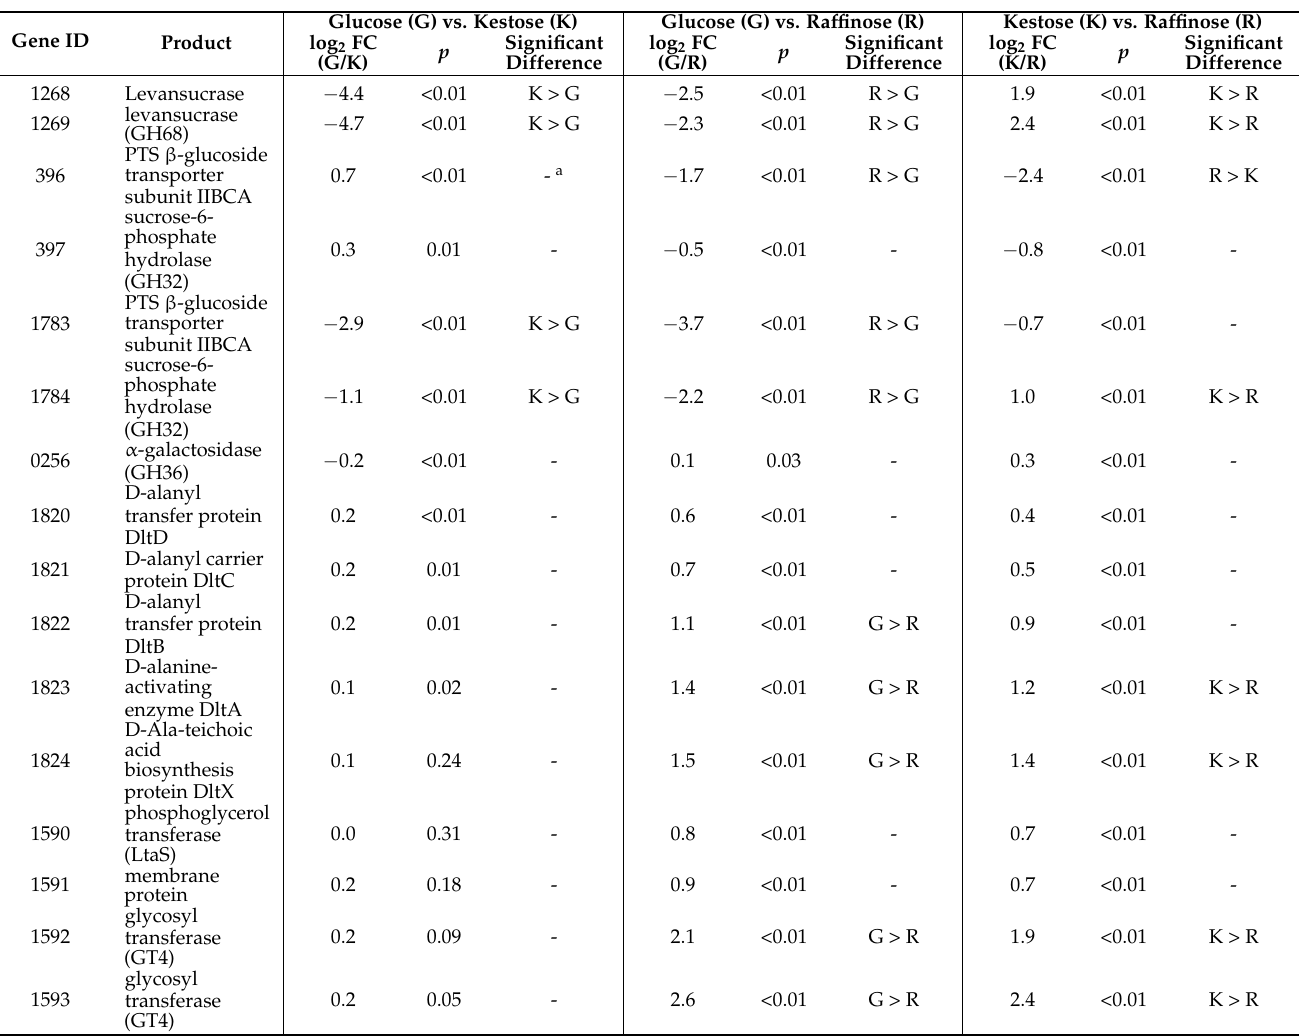
Table 3. Comparison of gene expression levels in L. gasseri JCM 1131 T cells in the presence of different